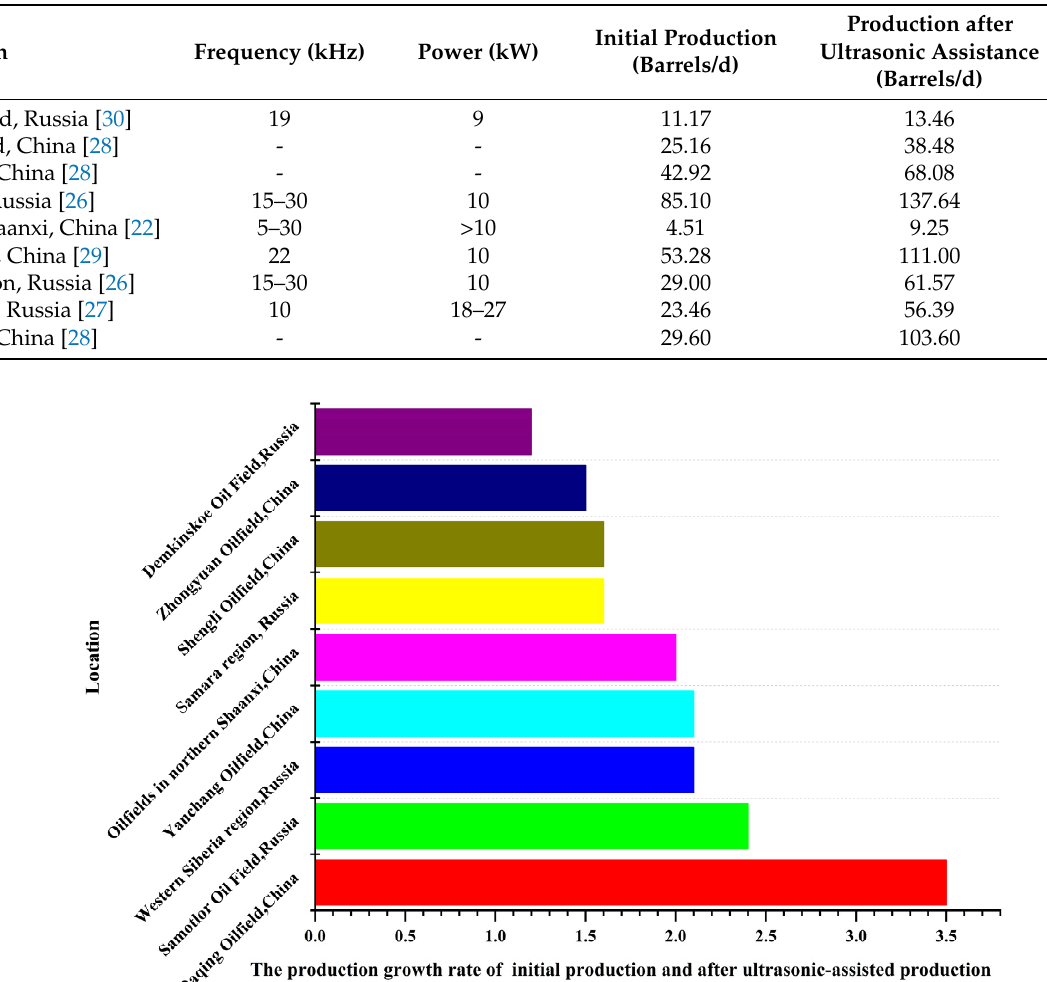
Table 1. Compare initial production and after ultrasonic-assisted production in different locations.